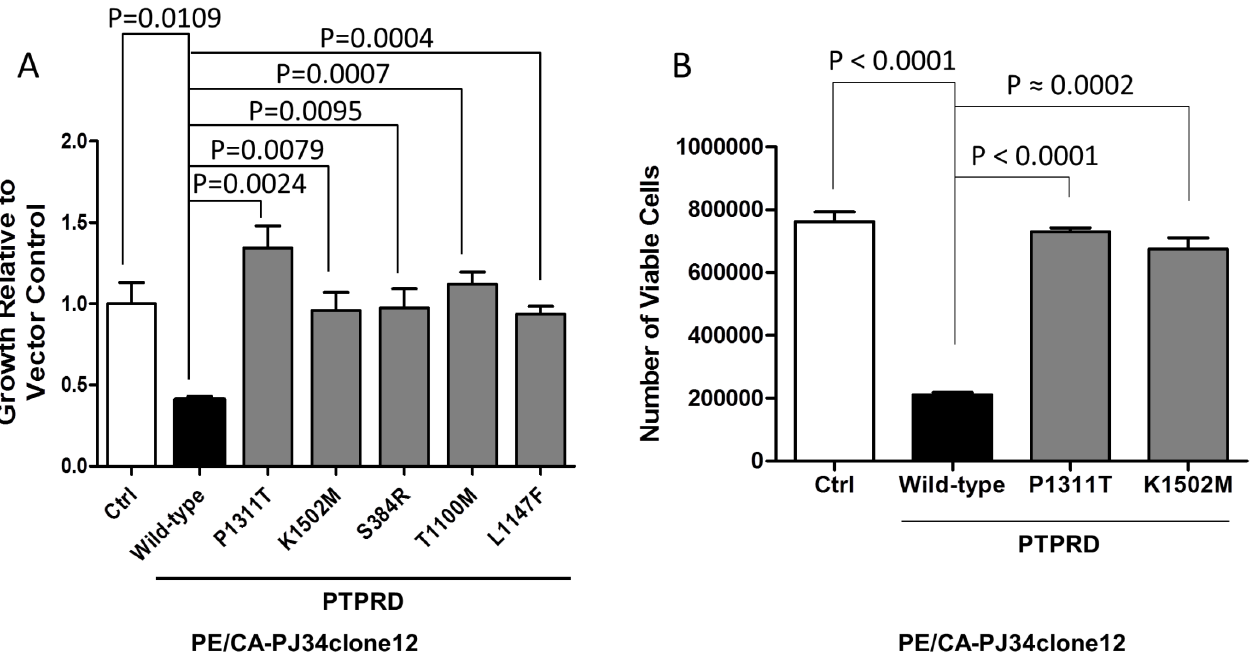
Fig 2. HNSCC-derived PTPRD mutations lead to increased cell growth/proliferation in HNSCC cells. (A) Cell growth was assessed by MTT assay 48 hrs after transfection and normalized to vector-transfected controls. One-way ANOVA P = 0.0007. Depicted P values represent the results of pairwise two- tailed unpaired t tests. The experiment was performed three times with similar results. (B) Cell proliferation was assessed by trypan blue exclusion assay 72 hrs after transfection. One-way ANOVA P < 0.0001. Depicted P values represent the results of pairwise two-tailed unpaired t tests.